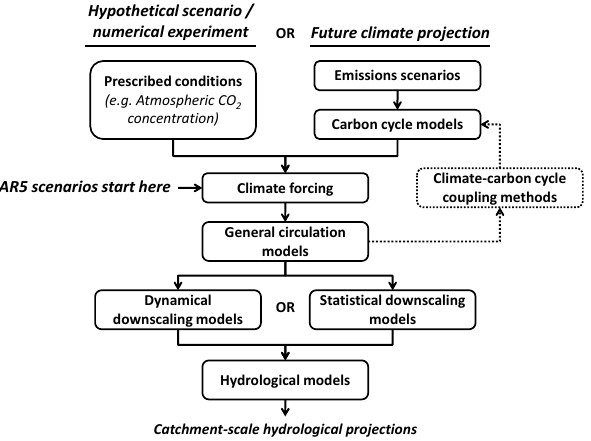
Fig. 1. Simplified chart of the main processes involved in model- ing hydrological impacts from climate change. Note: Dashed lines around climate-carbon cycle coupling methods indicate that not all models are